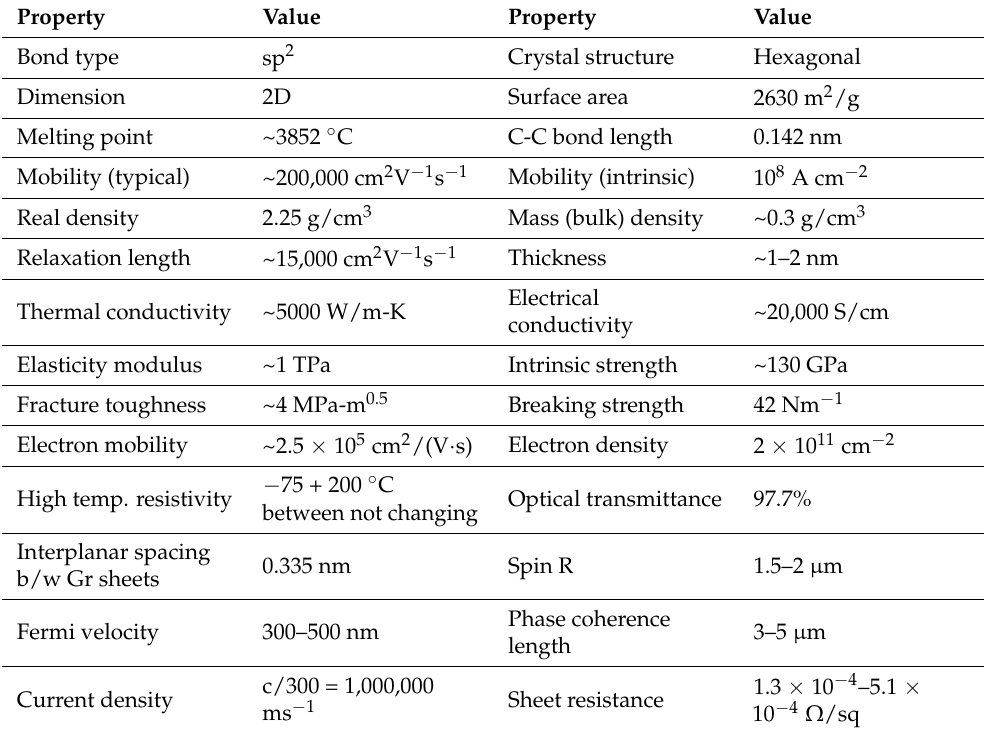
Table 1. Properties of single-layered graphene